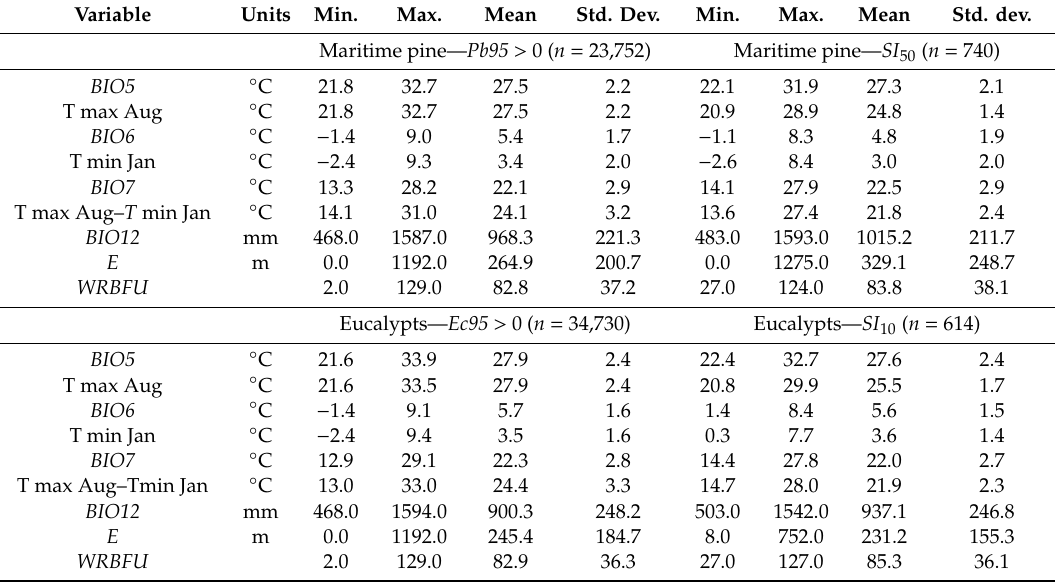
Table 6. Summary data for species distribution and productivity: (a) Maritime pine presence in COS 1995 ( Pb95 > 0); (b) Maritime pine productivity in 1990–1994 plots ( SI 50 ); c) Eucalypts presence in COS 1995 ( Ec95 > 0); (d) Eucalypts productivity in 1990–1994 plots ( SI 10 ). Variable Units Min. Max.